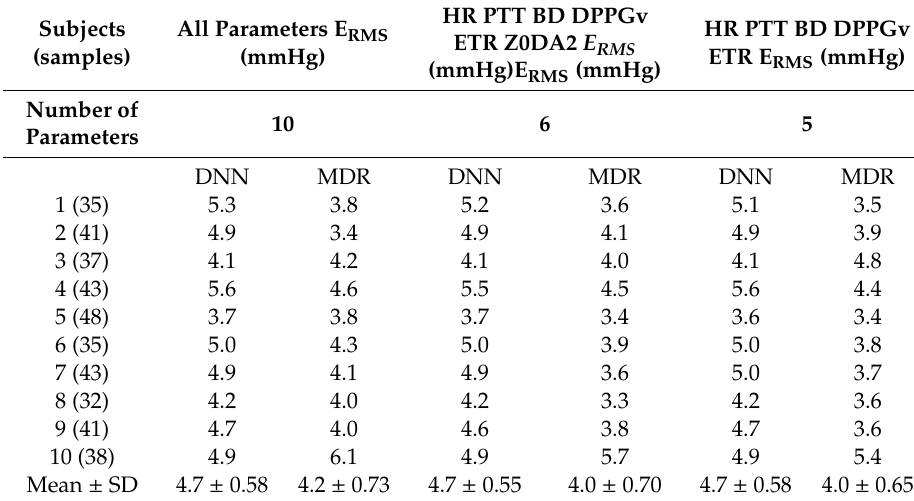
Table 6. The E RMS statistics (mean ± SD) of the estimated diastolic pressure for the ten subjects with the parameters of pulse wave and